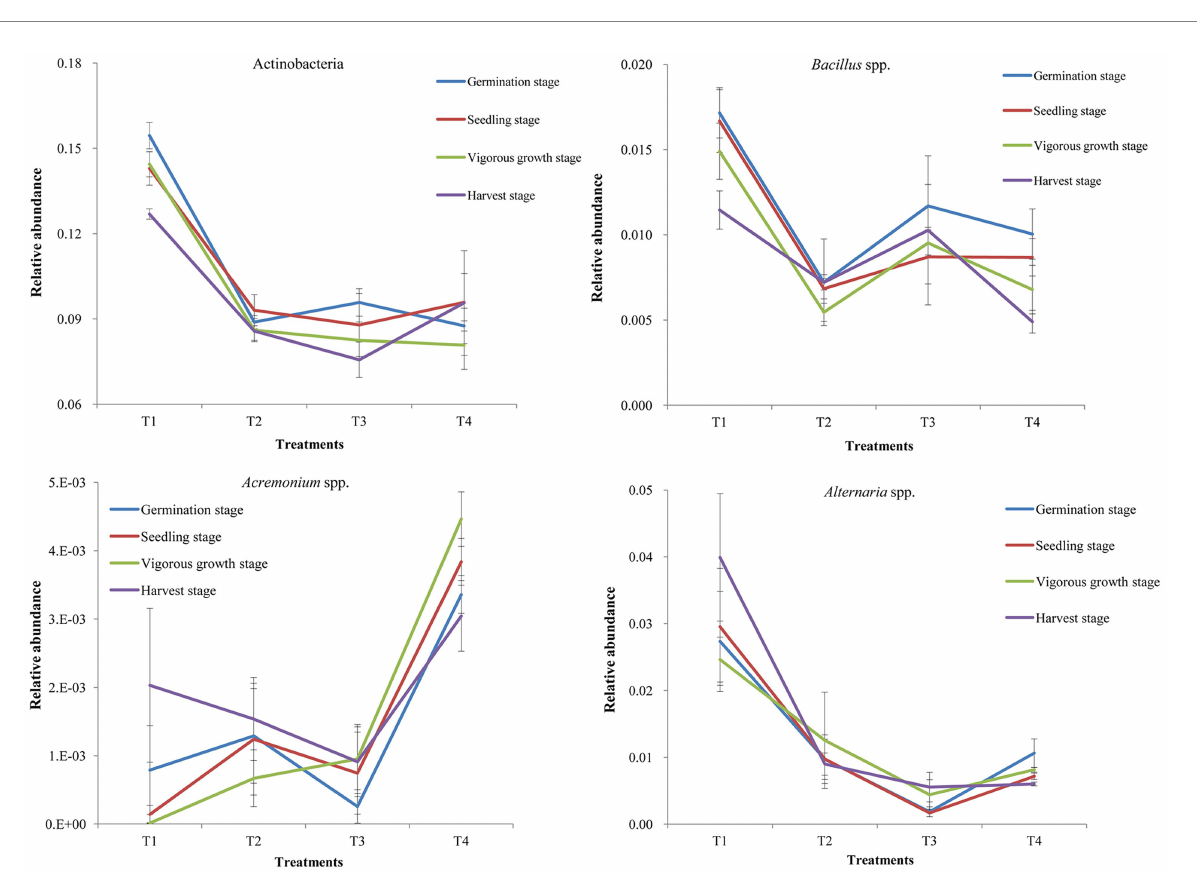
FIGURE 4 Relative abundance of probiotic bacterial Actinobacteria and Bacillus spp., and pathogenic fungal Acremonium spp. and Alternaria spp. in the samples collected at different growth stages. T1, soil treated with R. palustris PSB-06 and dazomet; T2, soil treated with dazomet alone; T3, soil treated with R. palustris PSB-06 alone; T4, soil without treatment (blank control). The statistical differences between the treatments were determined using the Duncan’s Multiple Range Test (DMRT) at the 5%